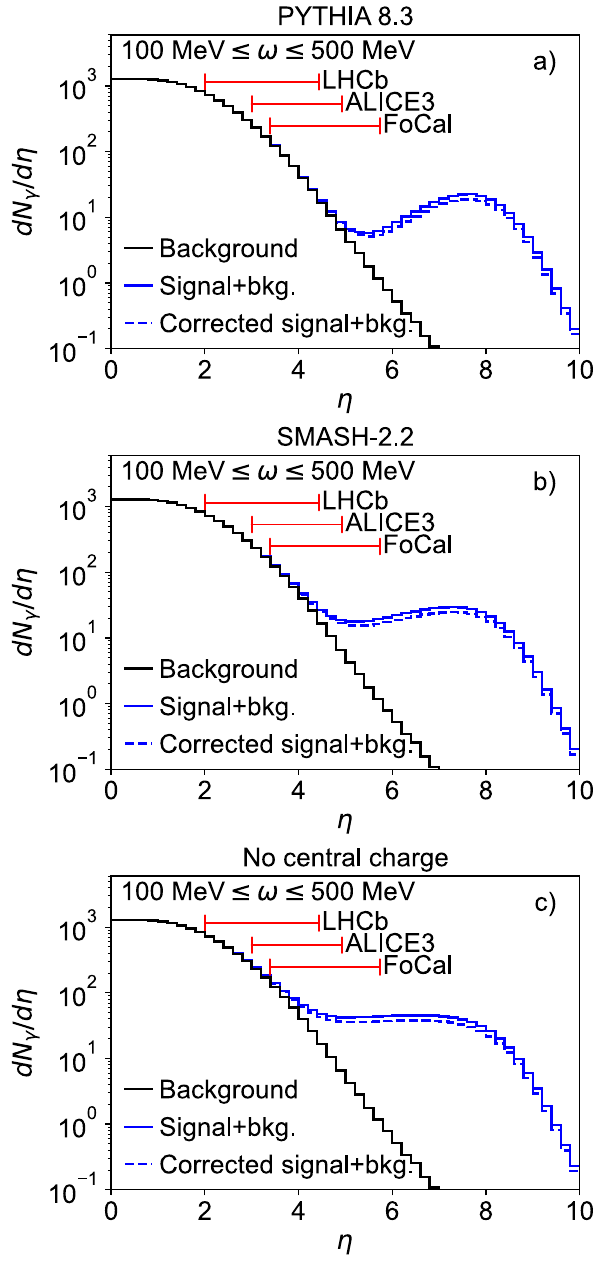
Fig. 3 The pseudorapidity distributions for photons with 0 . 1 ≤ ω ≤ 0 . 5GeVintegratedovertheazimuthalangle.Theblackhistogramshows the background from hadronically produced photons. The solid blue histogram shows the sum of the photons from bremsstrahlung radiation and hadronic production. The correction applied to the bremsstrahlung spectrum to obtain the dashed blue histogram is described in the